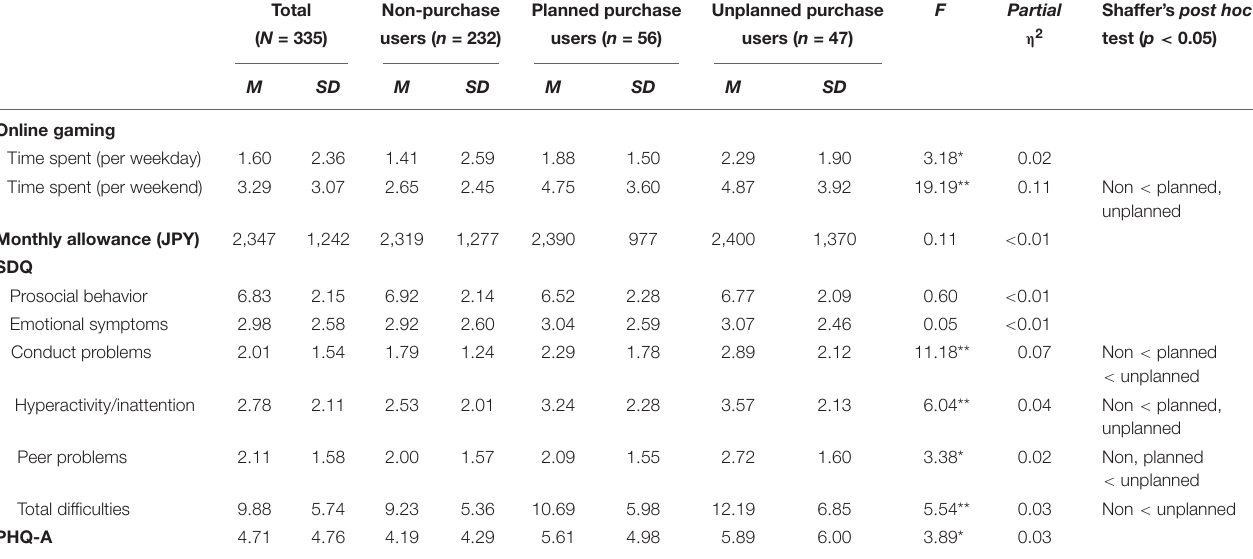
TABLE 3 | Comparison of user profiles, SDQ, and PHQ-A according to the styles of in-game